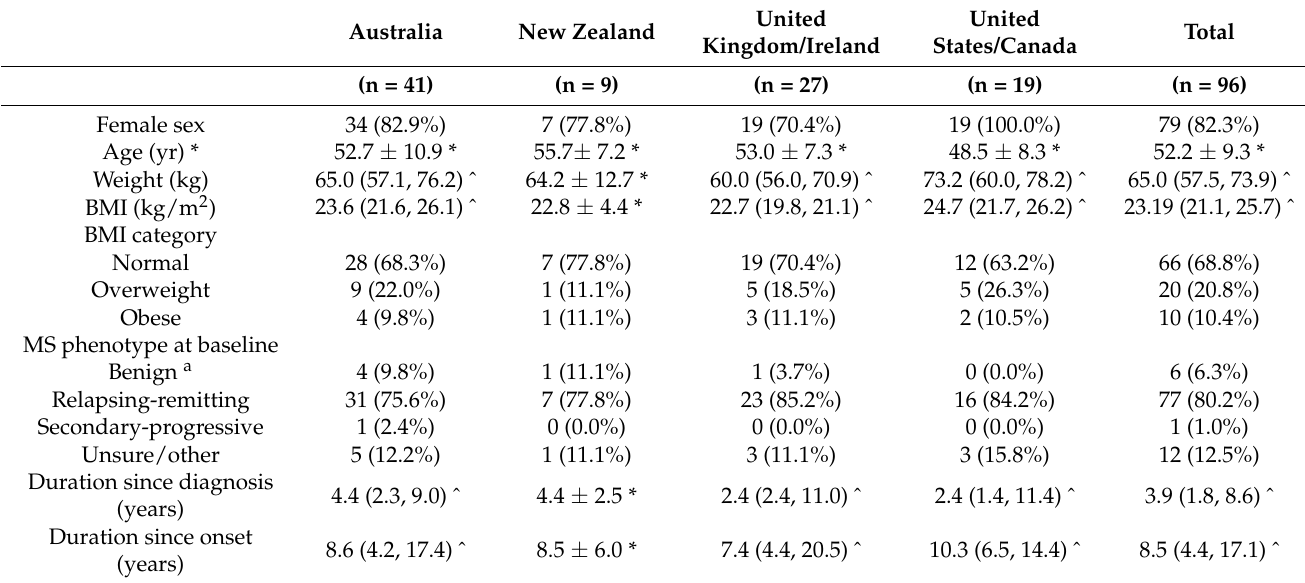
Table 1. Sociodemographic characteristics of the sub-sample from the Health Outcomes and Lifestyle In a Sample of people with Multiple sclerosis (HOLISM) cohort, presented for the total sample and by